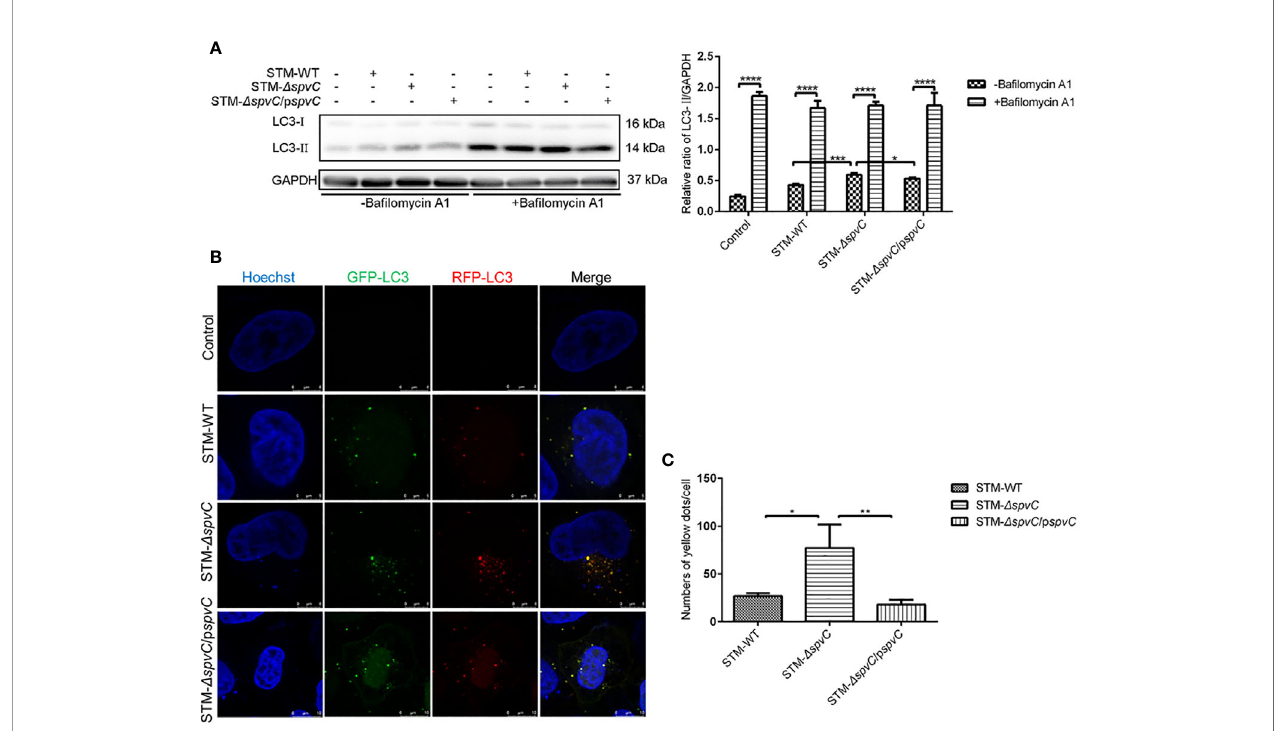
FIGURE 2 | SpvC inhibits the formation of autophagosomes in host cells during Salmonella Typhimurium infection. (A) J774A.1 cells were infected with STM-WT, STM- D spvC or STM- D spvC /p spvC at an MOI of 10 after being pretreated with Ba fi lomycin A1. Cell lysates were analysed by western blot with speci fi c antibodies to LC3 and the control GAPDH at 2 hpi. n = 3. (B, C) HeLa cells stability expressing mRFP-GFP-LC3 were used to establish an infection model. (B) LC3 puncta were visualized at 2 hpi by CLSM. Cell nucleus were labeled by Hoechst. (C) Punctate LC3 dots were measured by Image J. Number of punctate dots was enumerated in at least 100 cells. Scale bar, 5 µm. Data were compared by ANOVA. Values are expressed as the means ± S.D. and statistically signi fi cant differences are indicated. * P < 0.05; ** P < 0.01; *** P < 0.001; **** P <